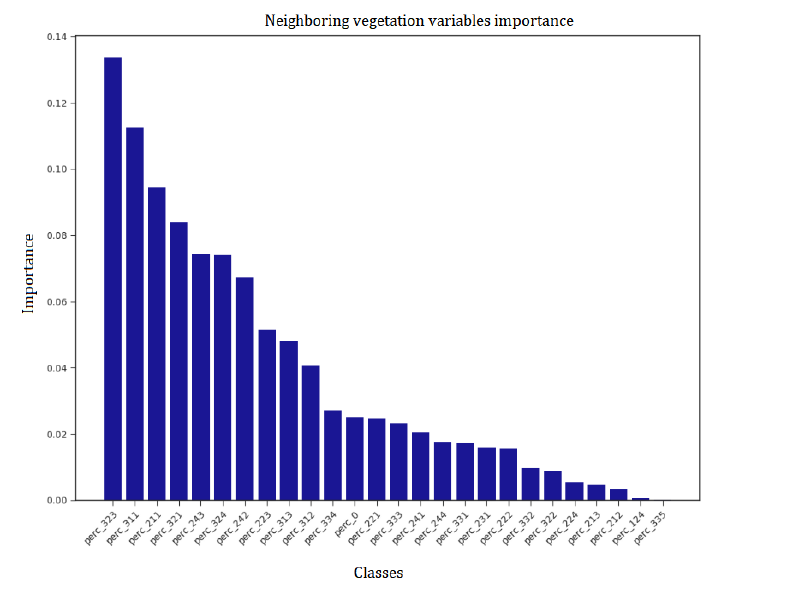
Figure 11. The neighboring vegetation feature importance for the summer season. The normalized output ranking is based on the mean decrease in Gini impurity associated with the ML